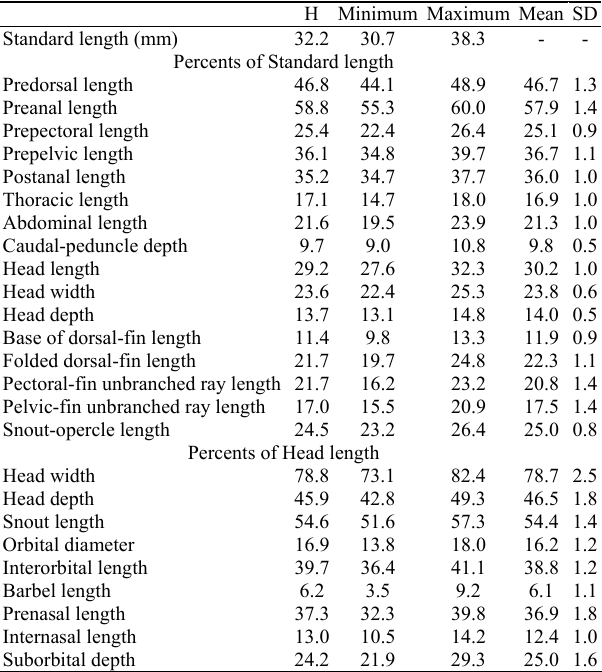
Table 1. Descriptive morphometrics of Rhinolekos britskii . Values given for holotype (H; DZSJRP 6489) and ranges of 30 specimens (DZSJRP 5614, 6514, 6884, 7018, 7036, 7042, 12190; MCP 44058; MNRJ 34128; MZUSP 103698); range includes holotype. SD = Standard